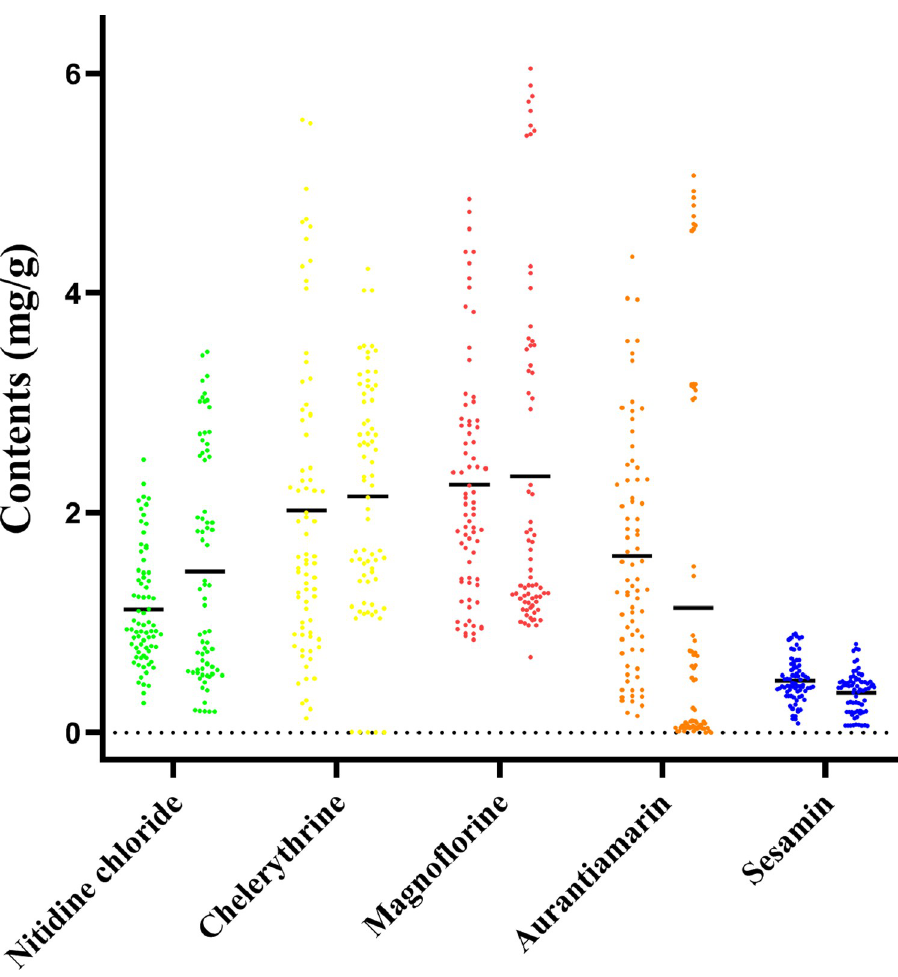
Fig 3. Distribution of five constituents of Z . nitidum . The right corresponds to wild samples, while the left corresponds to cultivated samples. The black horizontal lines indicate the mean values of different groups.